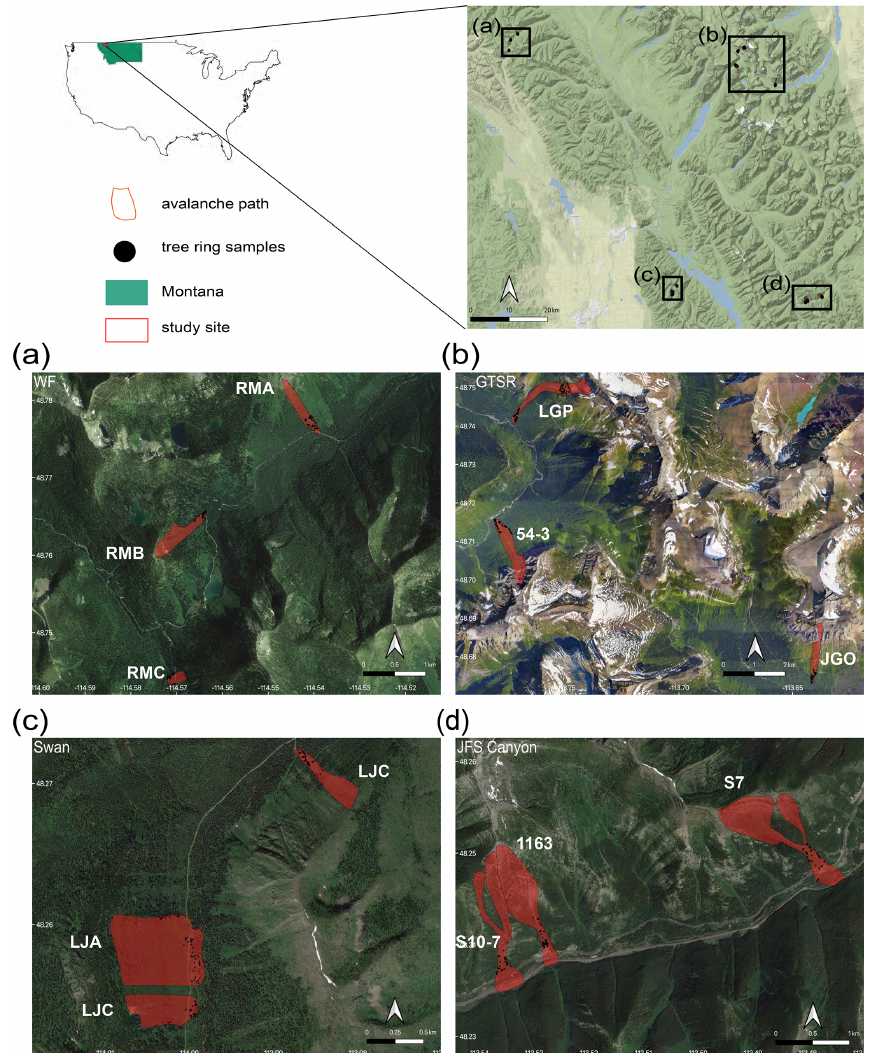
Figure 1. Study site. The red rectangle in the state of Montana designates the general area of the four sampling sites. The sites are (a) Red Meadow, Whitefish Range (WF), (b) Going-to-the-Sun Road (GTSR), central GNP, (c) Lost Johnny Creek, northern Swan Range (Swan), and (d) John F. Stevens Canyon (JFS), southern GNP. Black dots represent sample locations. Abbreviated names of each path are in white text adjacent to red polygons (paths). Satellite and map imagery: © Google (2020). Maps produced using ggmap in R (Korpela et al.,